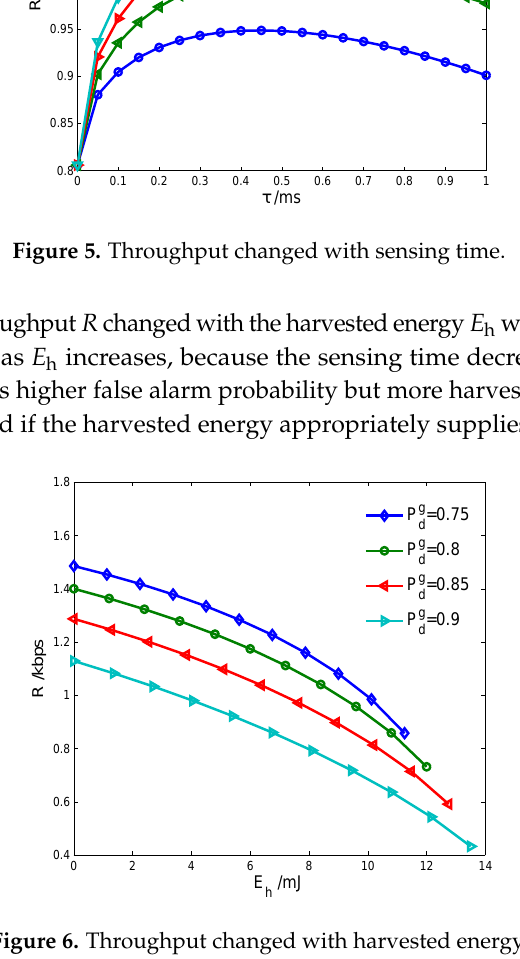
Figure 6. Throughput changed with harvested